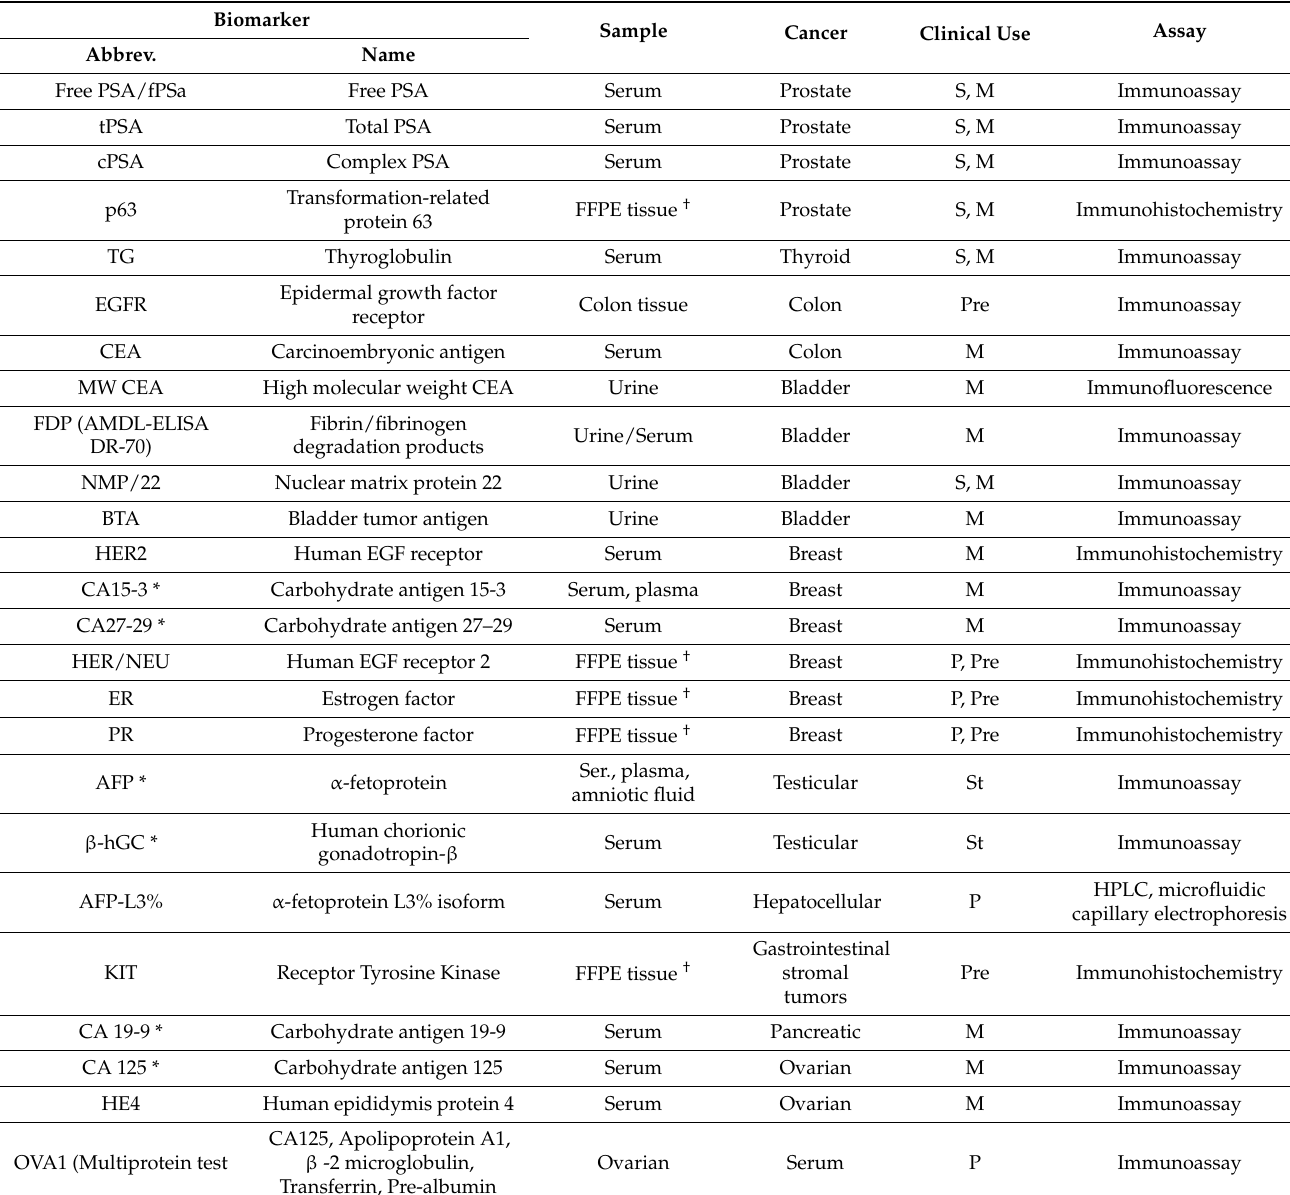
Table 1. Cancer biomarker proteins approved by the US FDA